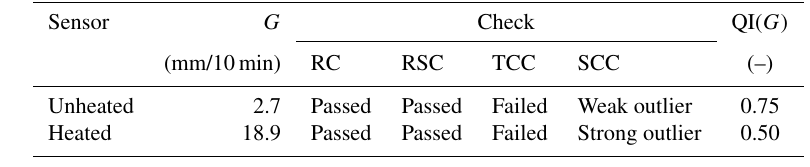
Table 2. Results of QC of the Nowa Wie´s Podgórna rain station on 22 June 2021 at 13:30UTC.